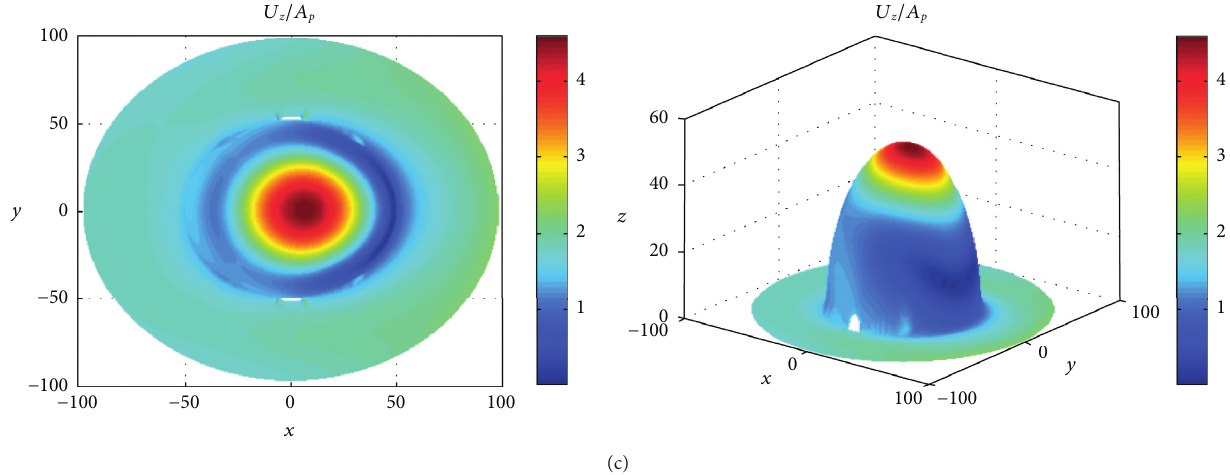
Figure 8: Surface displacement amplitude of the 3D tunnel mountain under the incident P wave ( η � 1 . 0 , α � 30 ° ): (a) surface displacement amplitude in x direction; (b) surface displacement amplitude in y direction; (c) surface displacement amplitude in z